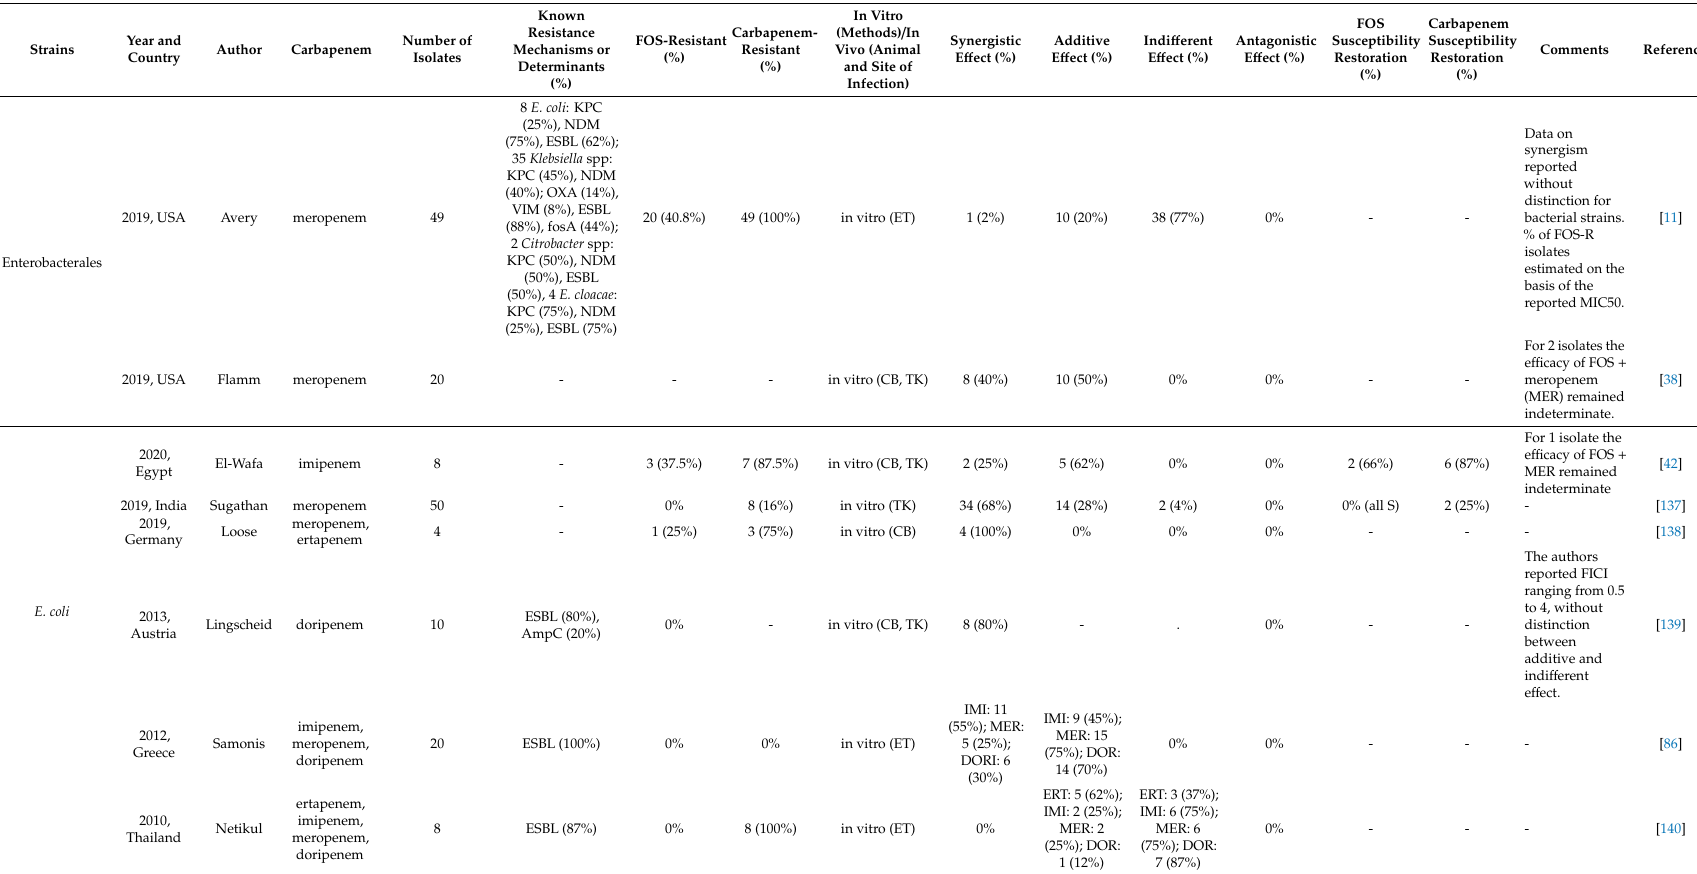
Table 3. Studies on combination between fosfomycin and carbapenems. CB: checkerboard assay; TK: time–kill assay; ET: